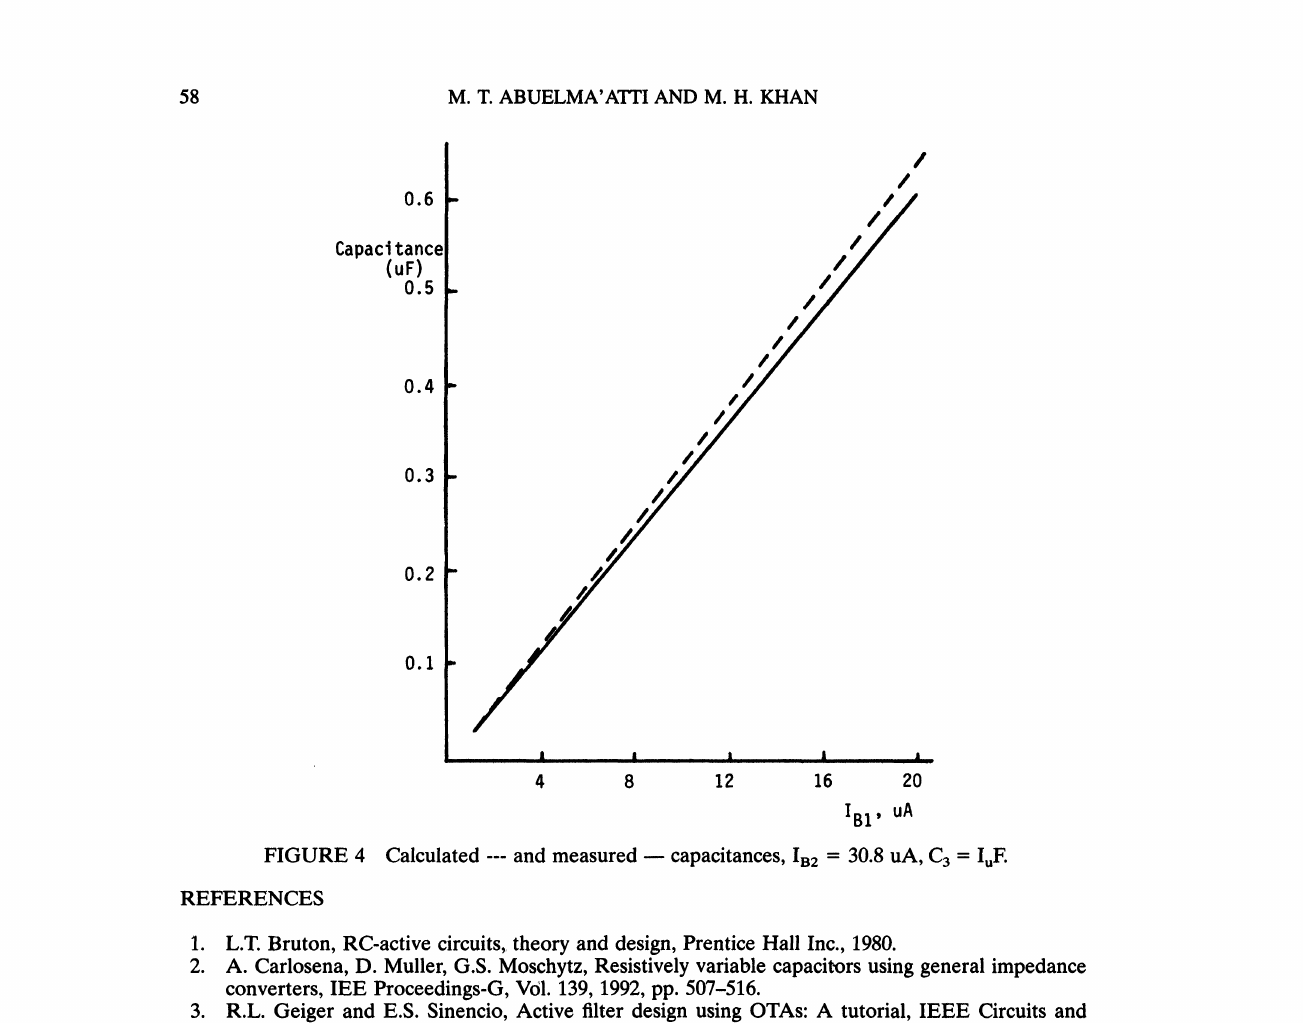
FIGURE 4 Calculated and measured capacitances, I 30.8 uA, C